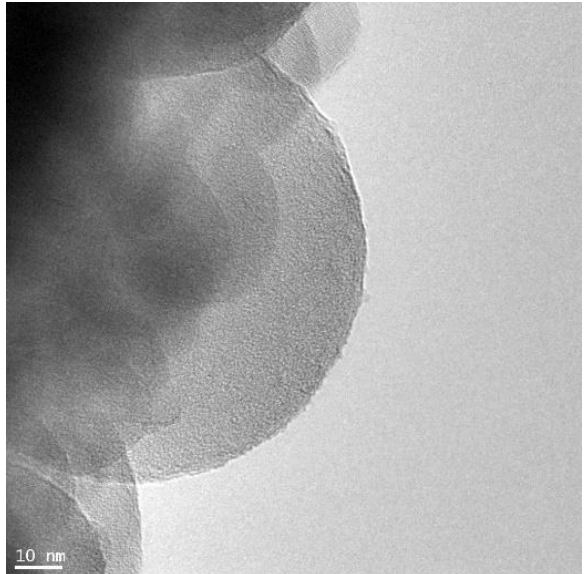
Figure 2. TEM images of nanosilica (NS).